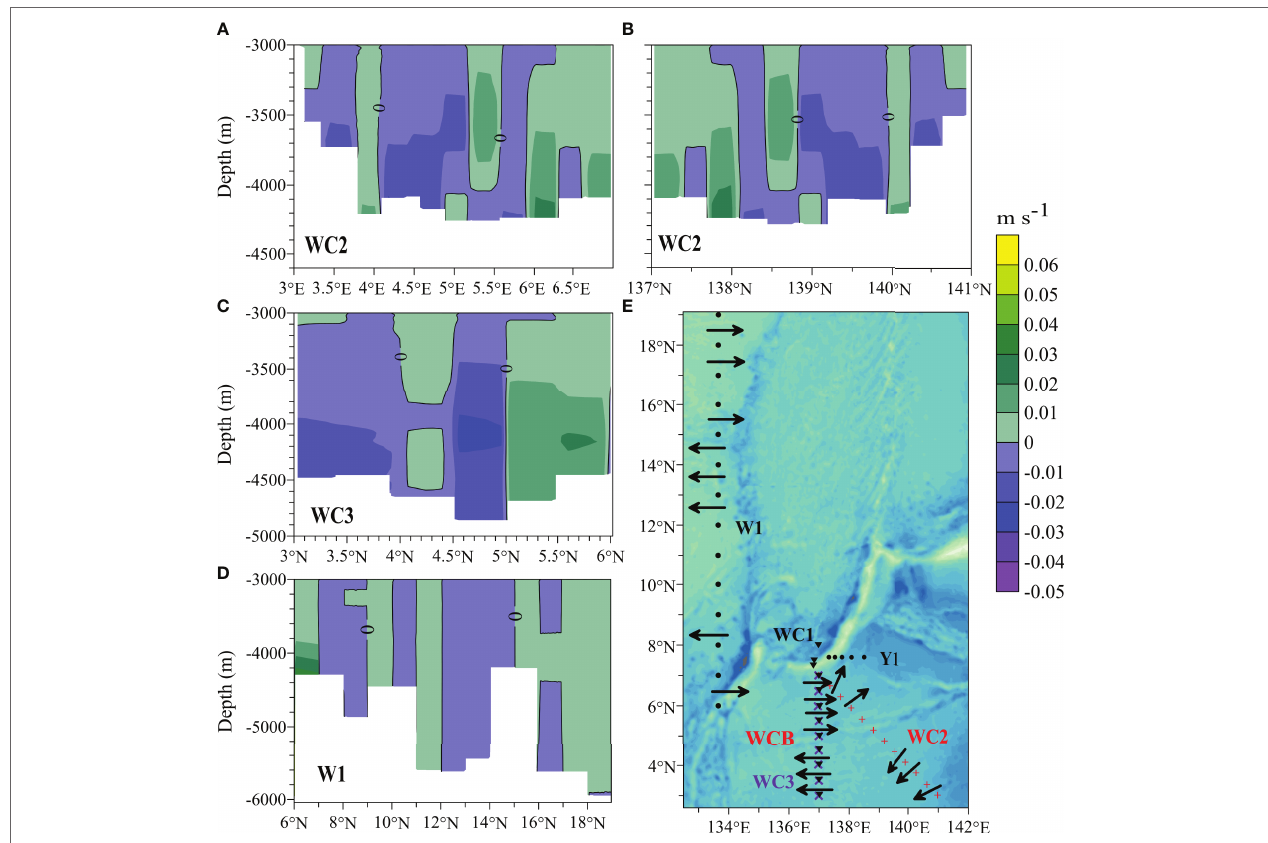
FIGURE 7 | Zonal (A) and meridional (B) flows at section WC2 in the West Caroline Basin, zonal flows at section WC3 (C) in the West Caroline Basin, zonal flows at section W1 (D) that crosses the Palau Trench in the West Caroline Basin and extends to the Philippine Basin, and flow pattern along observation sections in the region (E)